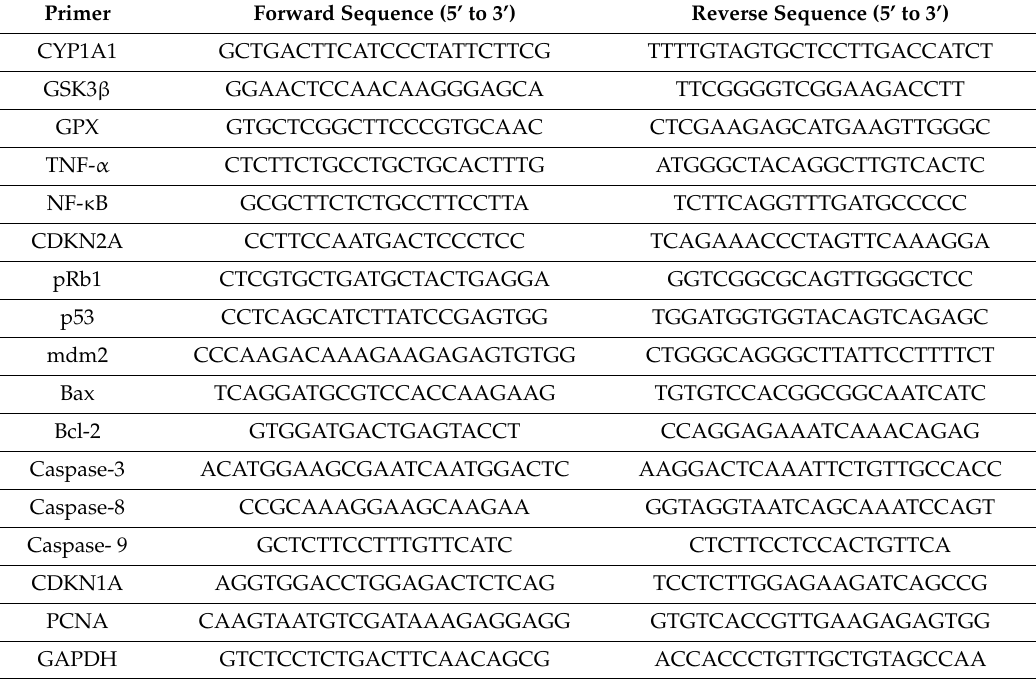
Table 2. Primers used in the Sybrgreen based real-time polymerase chain reaction